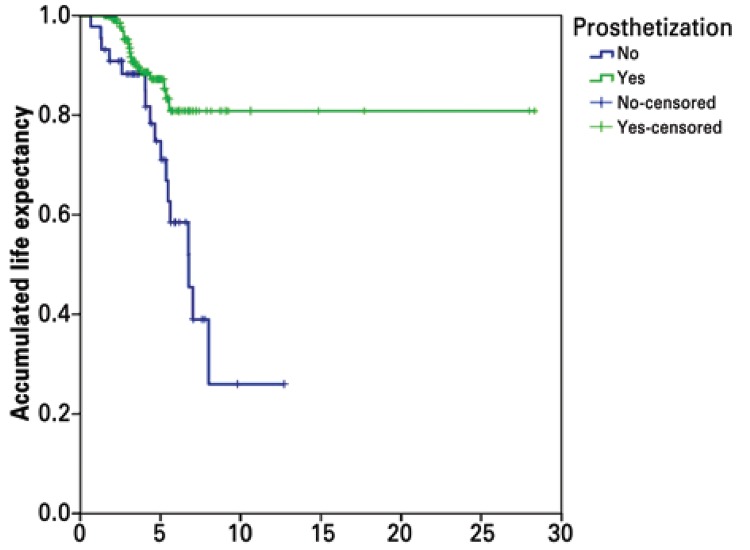
Kapla-Meier life expectancy graphic